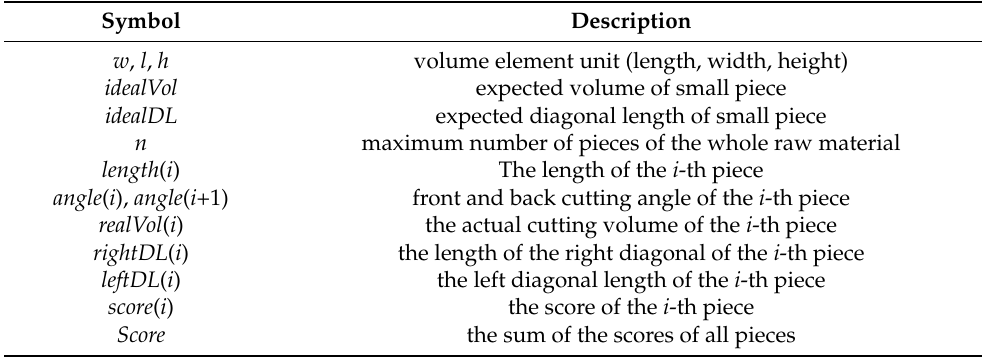
Table 1. Main parameters used for the cutting problem.